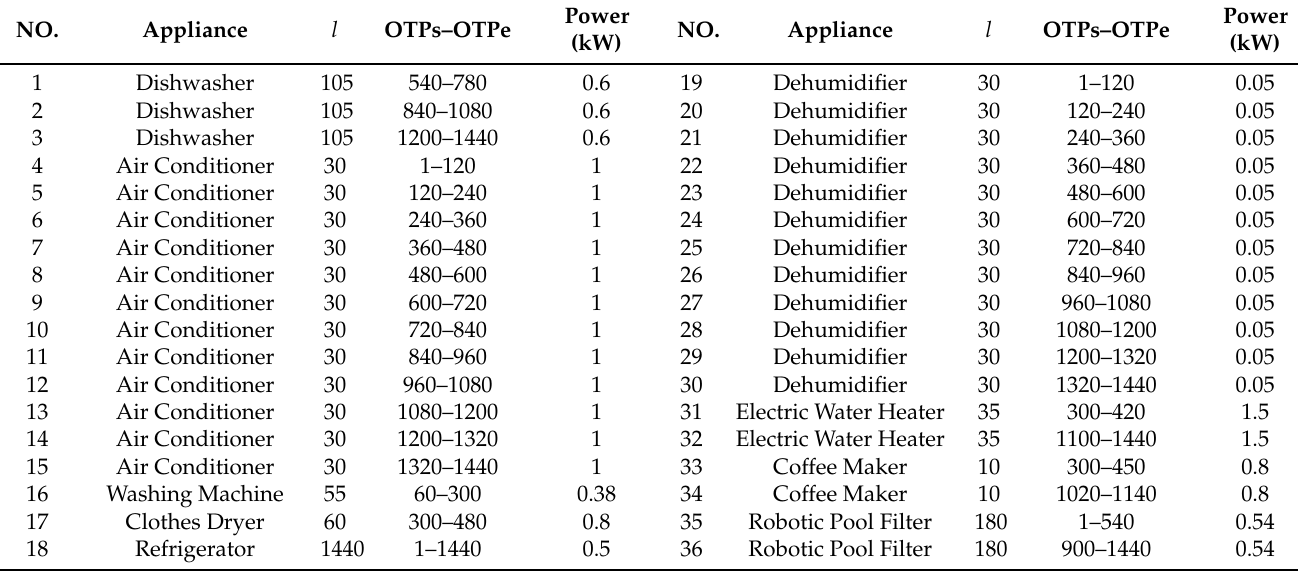
Table 1. Characteristics of the smart home